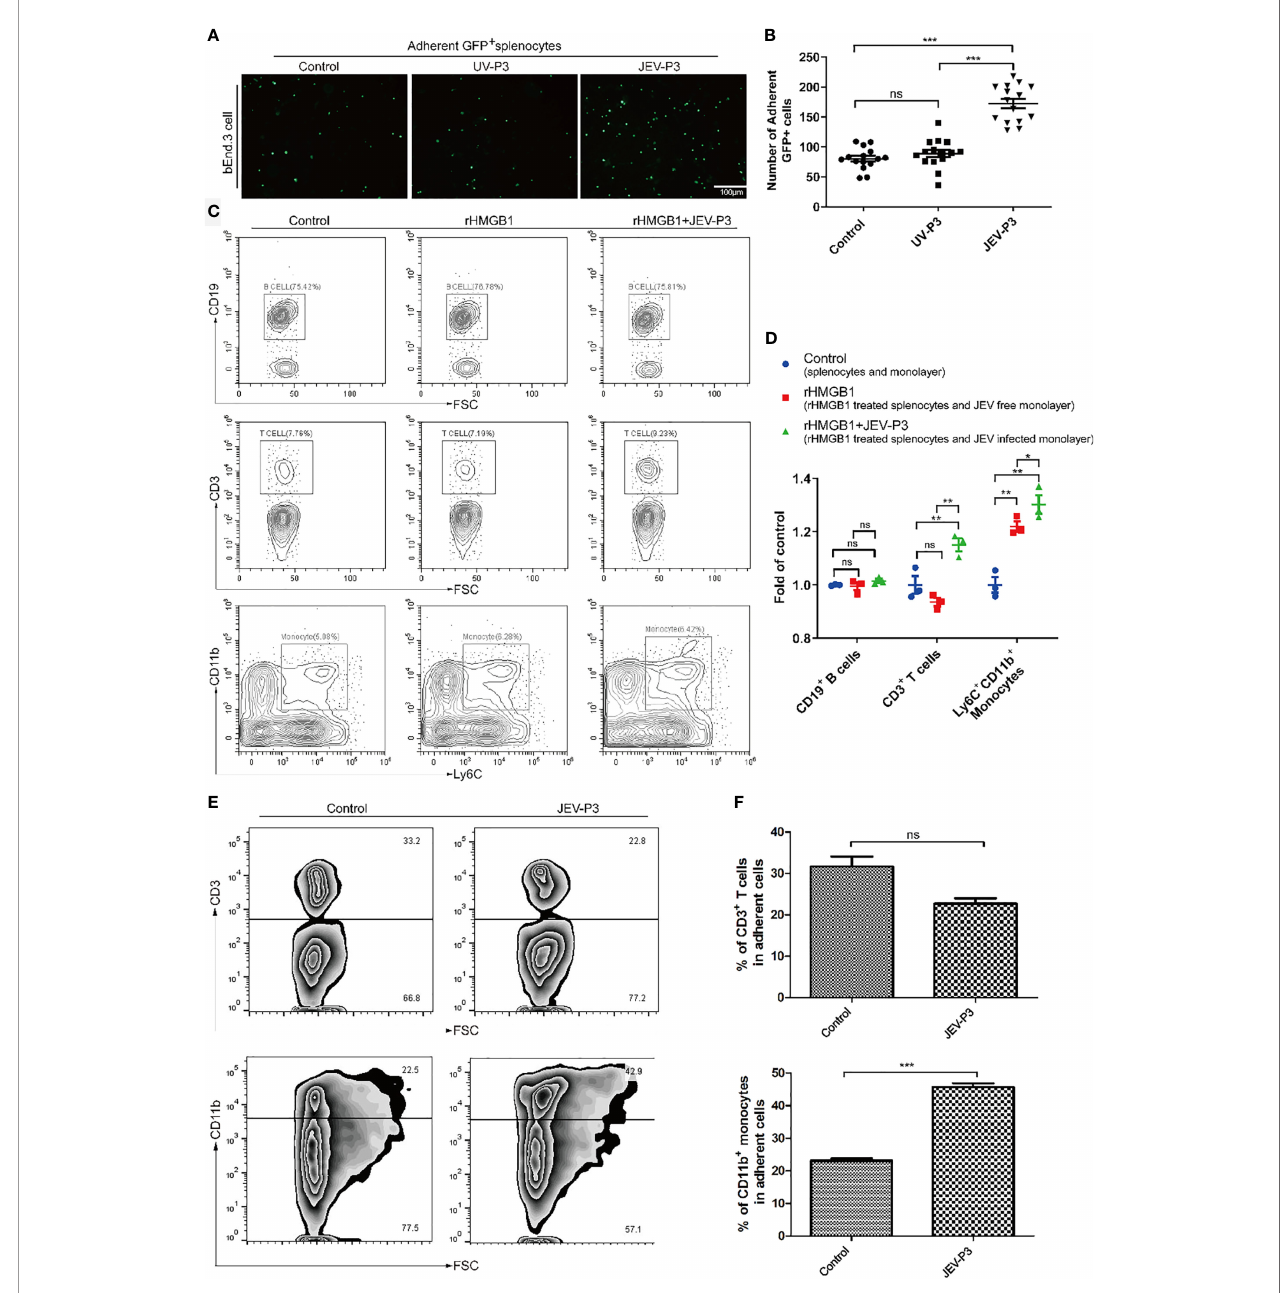
FIGURE 3 | HMGB1 promoted immune cell adhesion to the BMEC monolayer. (A) GFP + splenocytes were incubated with JEV-P3/UV-P3-infected bEnd.3 cell monolayers for 2 h; the GFP + splenocytes were obtained from transgenic mice. After washing with PBS, the cells were fi xed with 4% paraformaldehyde and then observed by fl uorescence microscopy. The fl uorescence represents the number of adherent splenocytes. JEV free monolayers were served as control. (B) Statistical analysis of the GFP + splenocytes binding to the bEnd.3 cell monolayer of (A) . (C) Mouse splenocytes were treated with rHMGB1 (100 ng/ml) for 2 h. Then, splenocytes (rHMGB1 treated or untreated) were incubated with the bEnd.3 cell monolayers (JEV infected or uninfected) for 2 h. After gentle washing with PBS, the adherent splenocytes were collected, and the amount of CD19 + B cells, CD3 + T cells, and Ly6C + CD11b + monocytes was analyzed by fl ow cytometry. Untreated splenocytes and uninfected monolayers were served as control. (D) Statistical analysis of the binding splenocytes to the bEnd.3 cell monolayer as reported in (C) . (E) Puri fi ed CD3 + T cells and CD11b monocytes (obtained from JEV-infected mice, tail vein injection (F) , 3 dpi) were inoculated onto the virus-infected bEnd.3 cell monolayer and incubated for 2 h. After washing with PBS, the bound cells were detected by fl ow cytometry. The right panels show the results of the statistical analysis of CD3 + T cells and CD11b monocytes binding to the bEnd.3 cell monolayer of (E) . JEV free bEnd.3 cell monolayers were served as control. The scale bar for (A) is 100 m m. These experiments were repeated at least three times. The data are expressed as the means ± SEM. p > 0.05 (ns, no signi fi cant difference), * p < 0.05, ** p < 0.01, and *** p <